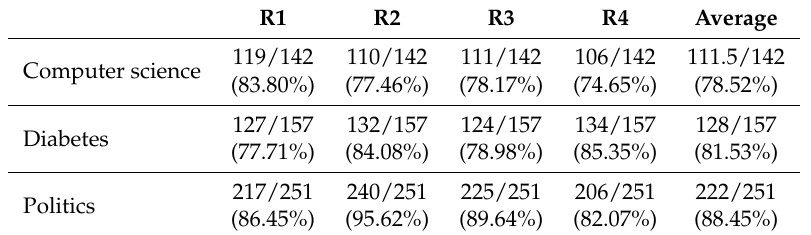
Table 11. Harvest Rate values for Wikipedia seed URLs per rater. R1 is for rater 1, R2 is for rater 2, etc.